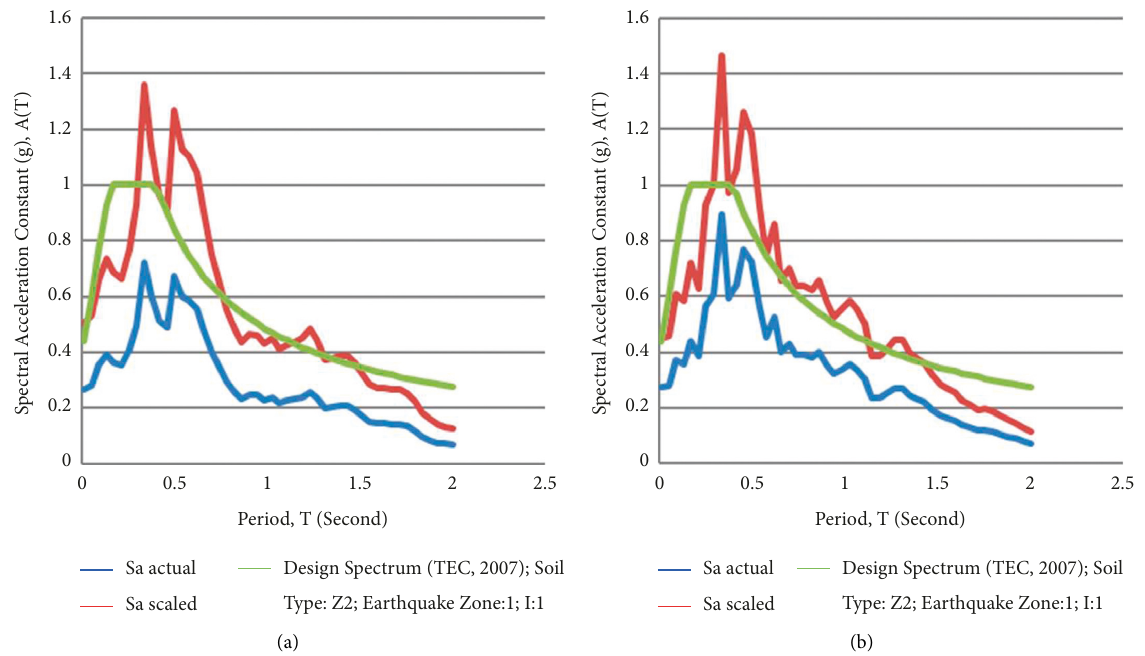
Figure 14: Evaluation of A(T) spectral acceleration constants for (a) North-South (N-S) and (b) East-West (E-W) components of earthquake with epicenter at Kayseri-Kocasinan ( M L : 4.8).